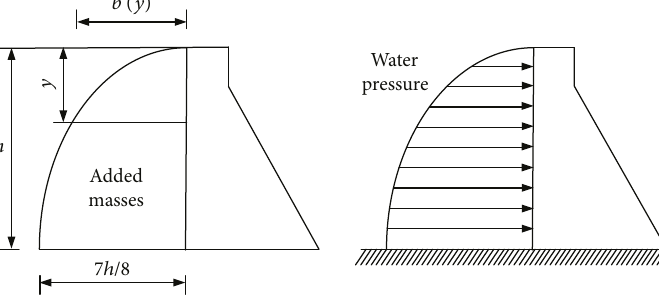
Figure 3: Westergaard dynamic water pressure and added mass on dam